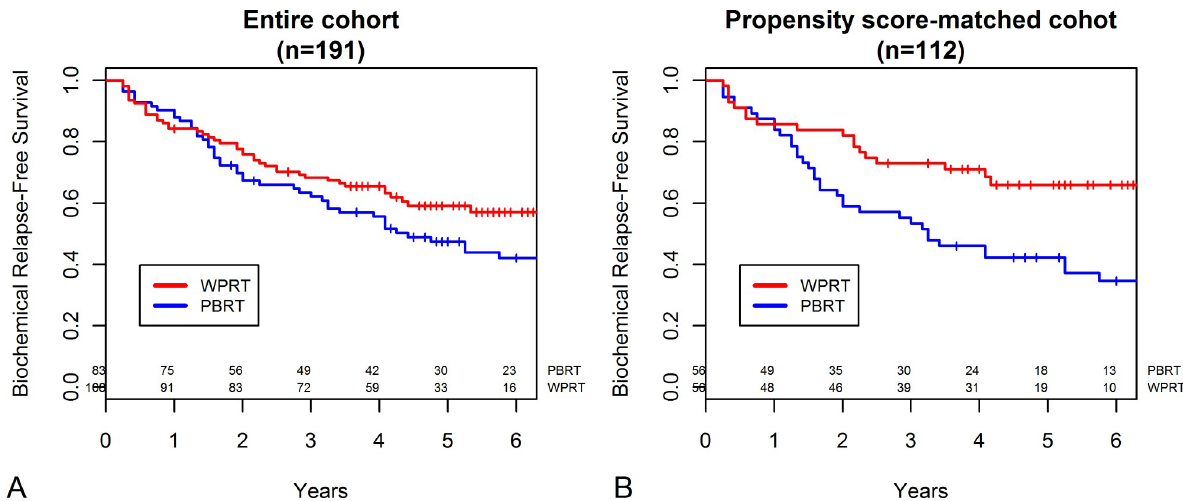
Fig 1. Biochemical relapse-free survival probability stratified based on receipt of whole pelvic radiotherapy (WPRT) or prostate bed-only radiotherapy (PBRT) in (A) the entire cohort (n = 191) and (B) the propensity score-matched cohort (n = 112).